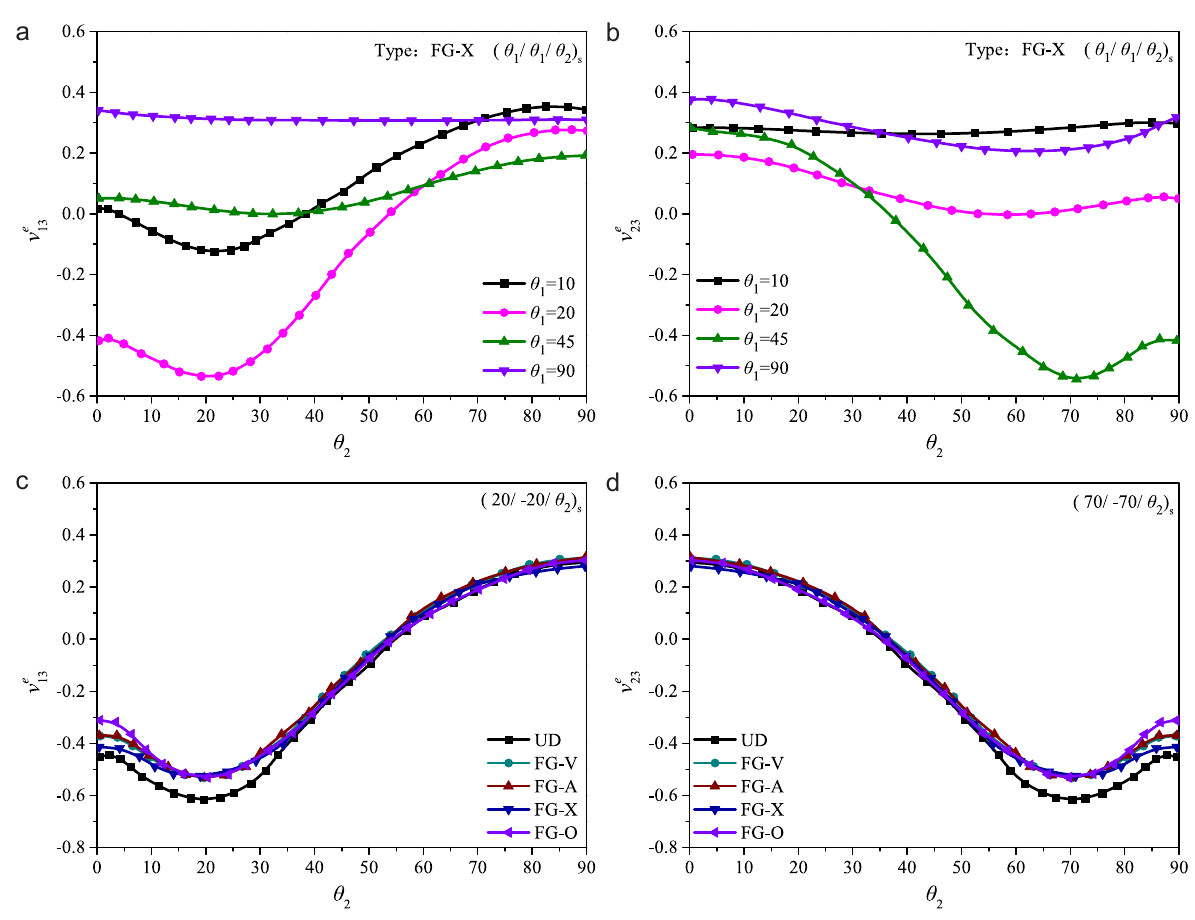
Figure 3. The effective Poisson’s ratios of FG-CNTRC laminated plates: ( a ) ν e laminates of type FG-X; ( b ) ν e for ( θ 1 / θ 1 / θ 2 ) s laminates of type FG-X; ( c ) ν e 23 laminates; and ( d ) ν e for (20/ − 20/ θ 2 ) s 23